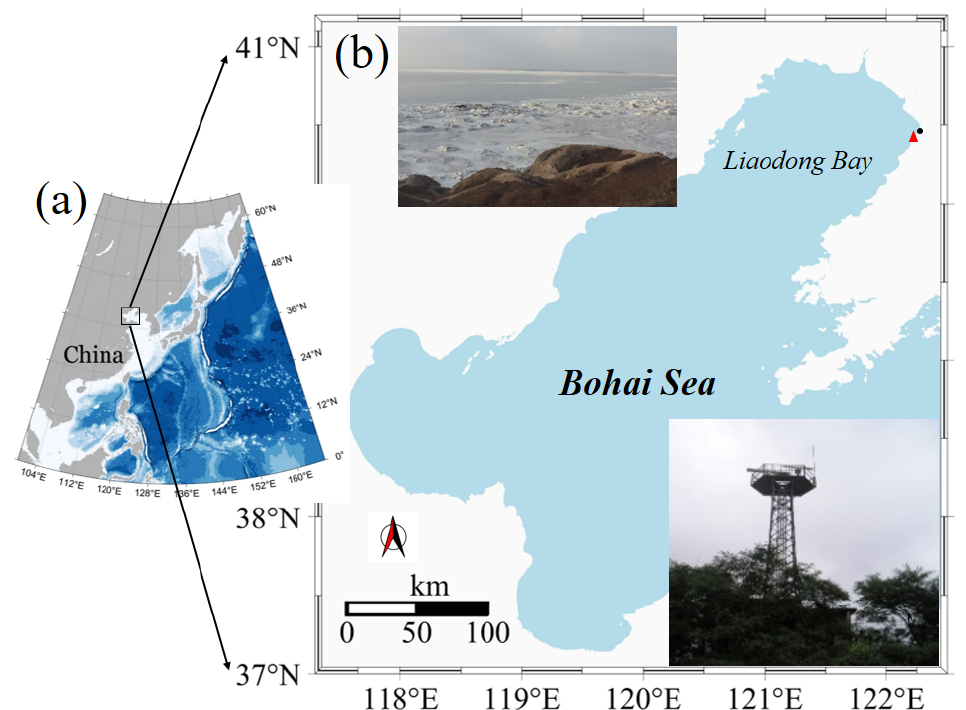
Figure 1. Geographical location of the Bohai Sea in the east coast of China in ( a ) and Liaodong Bay in the northern part of the Bohai Sea ( b ). The black dot ( ● ) is the Yingkou meteorological weather station, and the red triangle is the Bayuquan coastal radar position. The in situ observation was 4 km north of the Bayuquan coastal radar position. The top image is the Bayuquan coastal landfast ice, and the bottom right photo is the coastal radar. The distance between Yingkou meteorological weather station and Bayuquan coastal radar position is 10